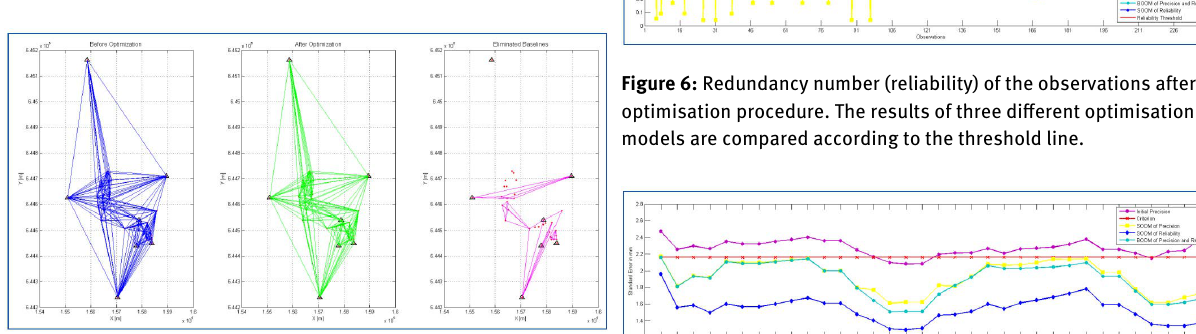
Figure 4: BOOM of precision and reliability, sensitive to detect 5 mm displacement. The panels from left to right illustrate the original network before optimisation, optimised one and removed base- lines, respectively.